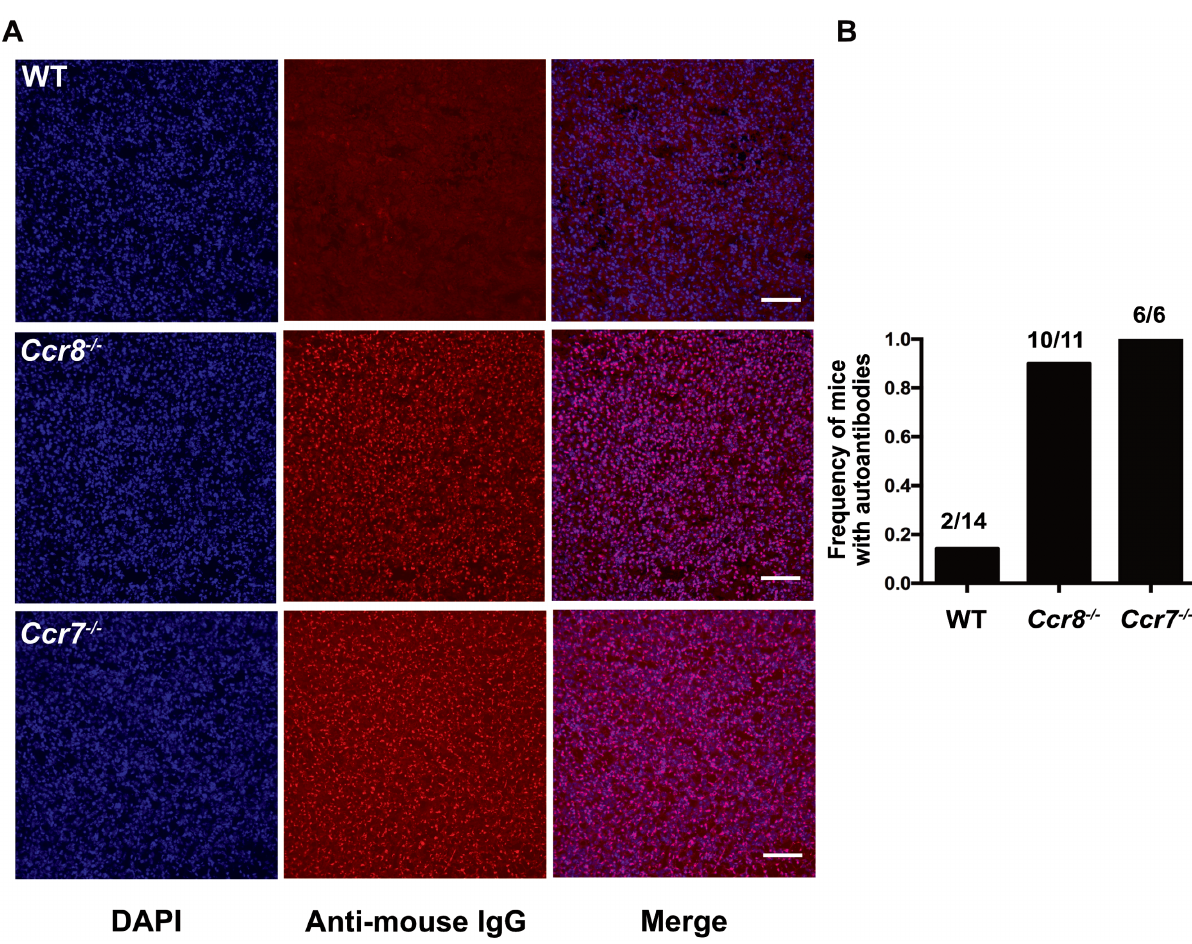
Fig 6. CCR8 deficiency results in increased production of autoantibodies. (A) Representative immunofluorescence images of kidney cryosections from Rag2 -/- mice immunostained with serum from 10–13 month old wild-type (WT) or Ccr8 -/- mice, or from 5–11 months old Ccr7 -/- mice. The presence or absence of autoantibodies was detected with anti-mouse IgG (red) and nuclei were stained with DAPI (blue). Scale bars 100 μ m. Images were taken at 20X magnification. (B) The proportion of aged mice containing serum autoantibodies was calculated from immunostaining as in (A). (cid:3)(cid:3)(cid:3) p < 0.0001 (Fisher’s exact